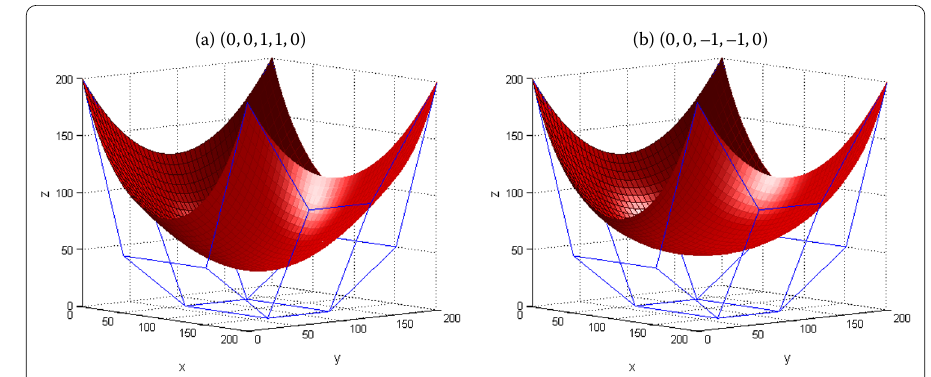
Figure 4 Shape modification of generalized Bézier-like surfaces with fixed